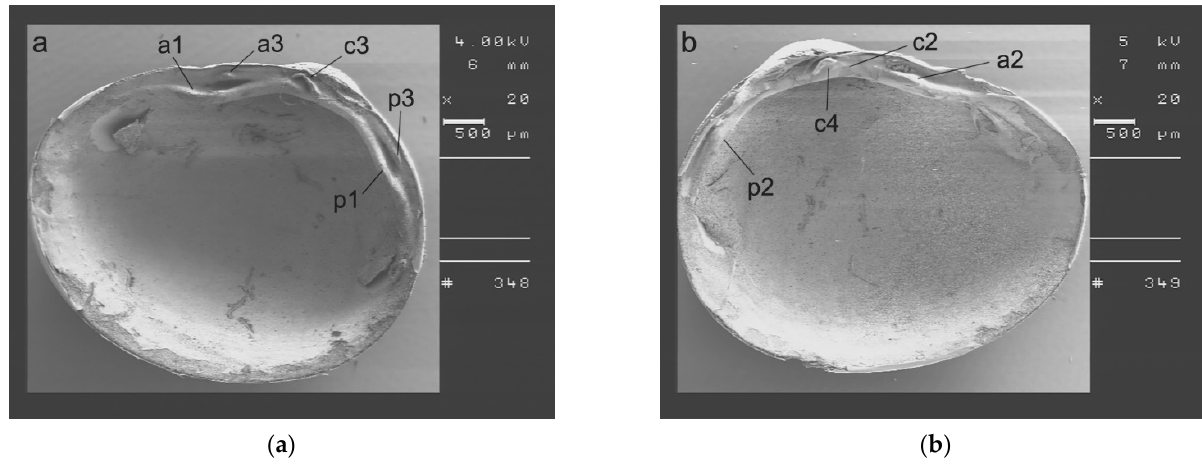
Figure 5. Morphometrics analyses of valves of P. casertanum . ( a ) Insight view of right valve with cardinal tooth c3, anterior lateral teeth a1 and a3, posterior lateral teeth p1 and p3. ( b ) Insight view of left valve with cardinal teeth c2 and c4, anterior lateral tooth a2, posterior lateral tooth p2.